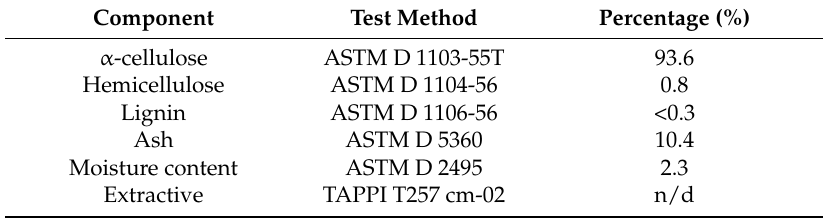
Table 4. Chemical compositions of the microcrystalline cellulose